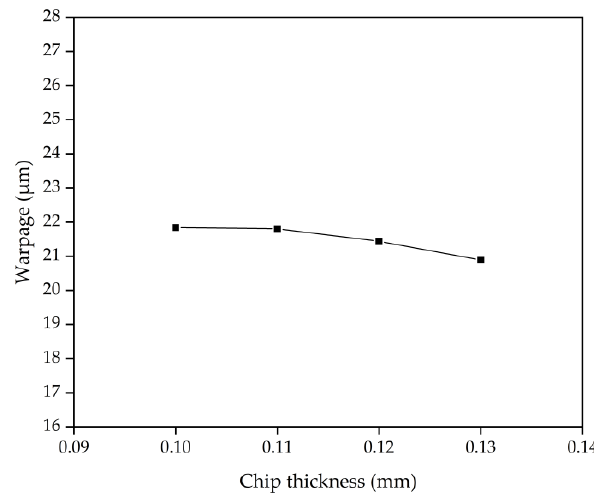
Figure 16. Influence of die thickness on warpage.